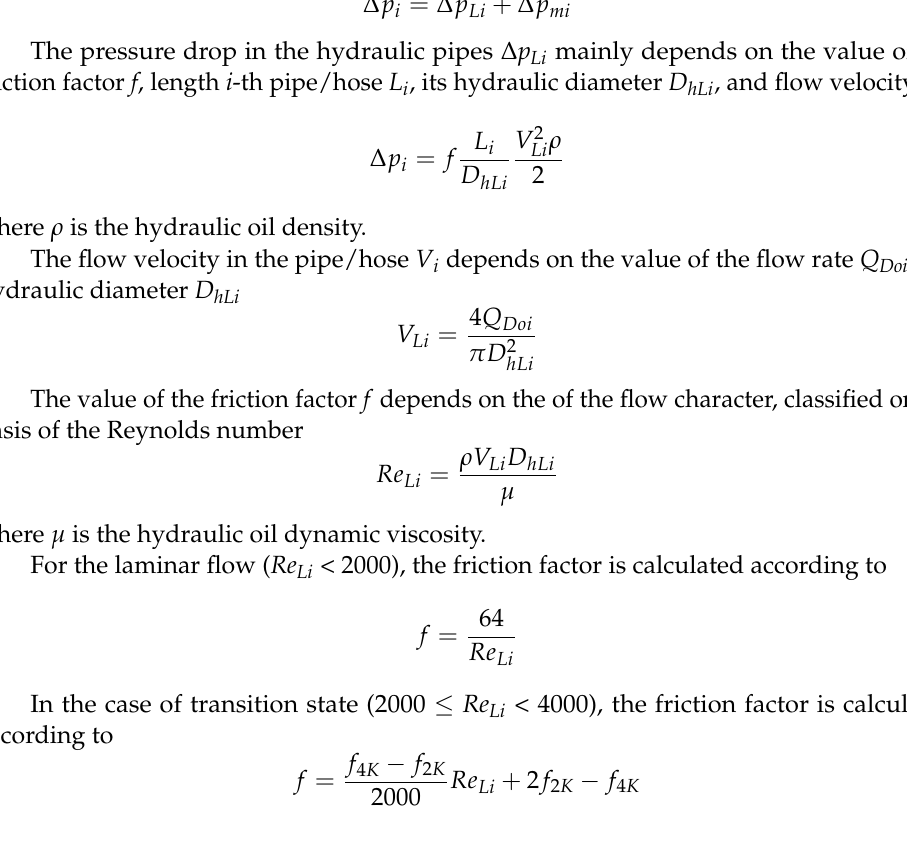
Figure 8. Concept of a hydrostatic drivetrain model for half vehicle body model. The pressure p Doi on the i -th output of the flow divider is greater than the value p Ini shown by the pressure drop value ∆ p i resulting from flow resistance occurring on the pipes ∆ p Li and hydraulic connections ∆ p mi , which are mounted between the divider and the